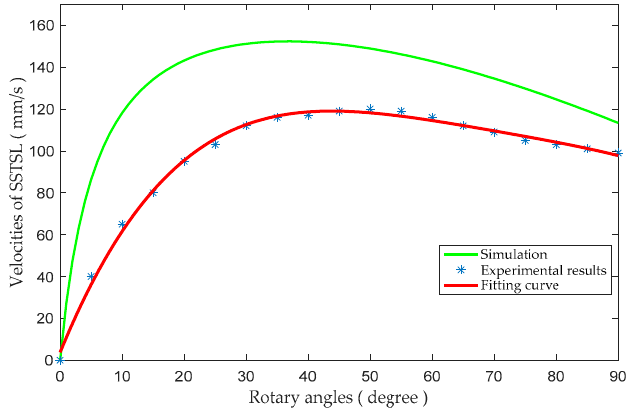
Figure 13. The velocities at different rotary angles of the horizontal servos.